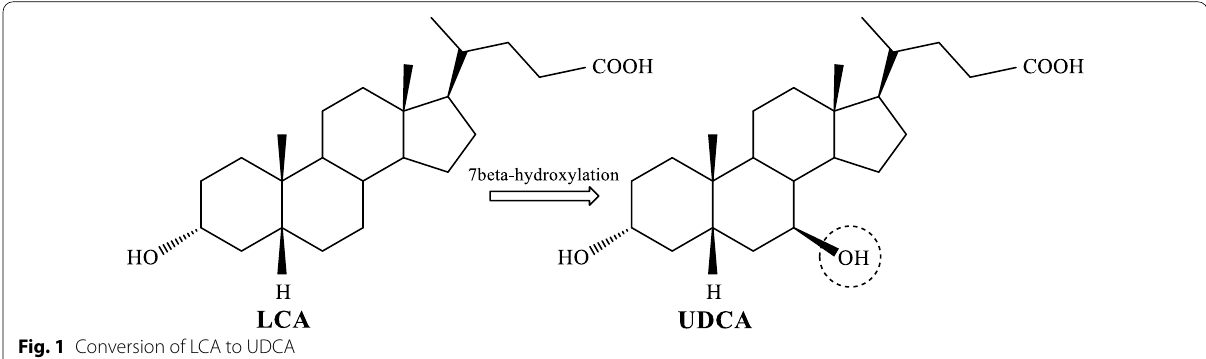
Fig. 1 Conversion of LCA to